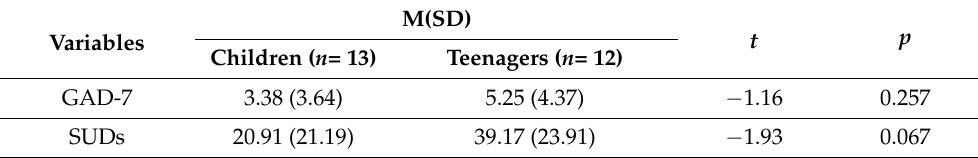
Table 5. The result of GAD-7 and SUDs between two population